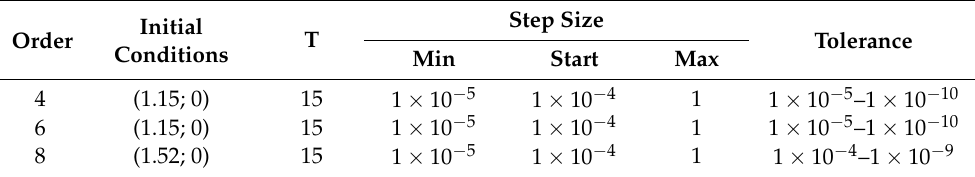
Table 4. Parameter values used in simulation of Van der Pol